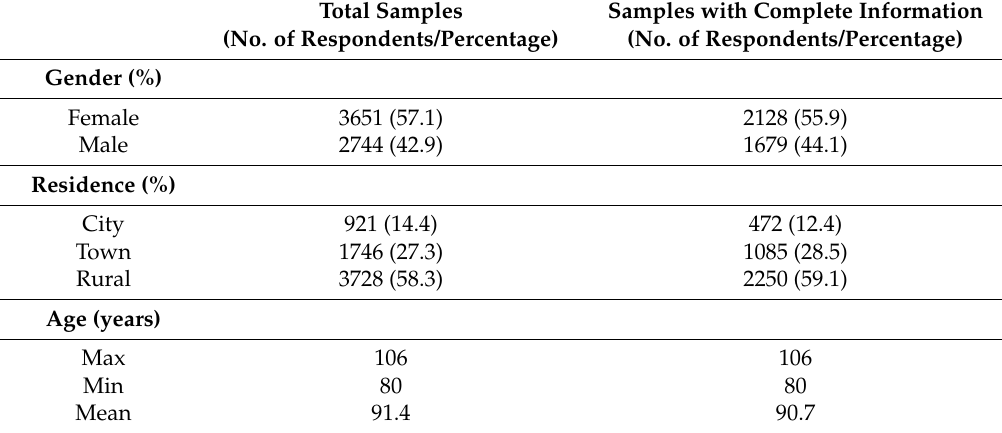
Table 1. Comparisons of samples before and after excluded cases were